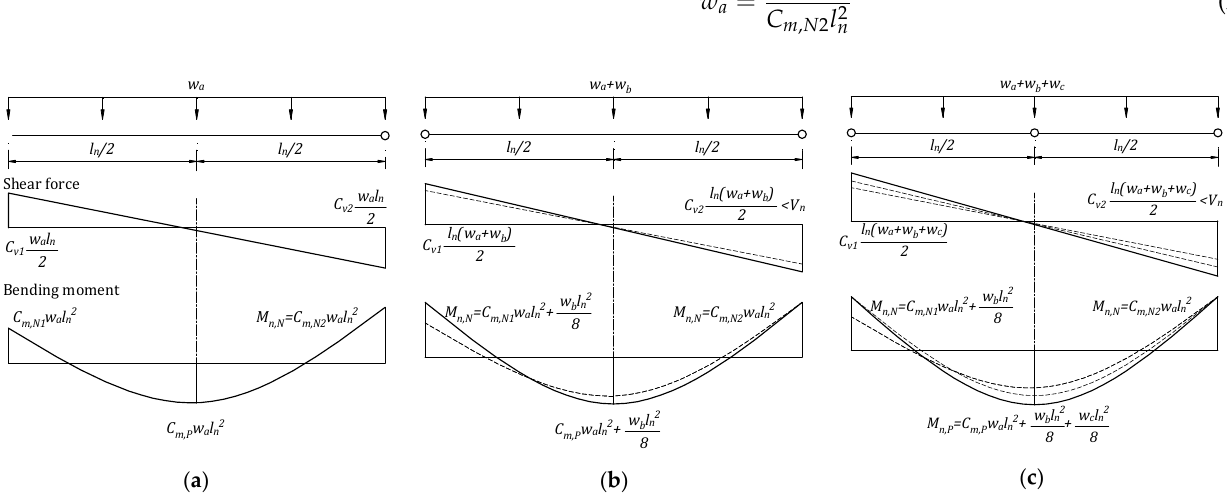
Figure A1. Failure mechanism for D-1 region. ( a ) Flexural failure at the N2 section first; next, ( b ) flexural failure at the N1 section; and finally, ( c ) flexural failure at the mid-span section.